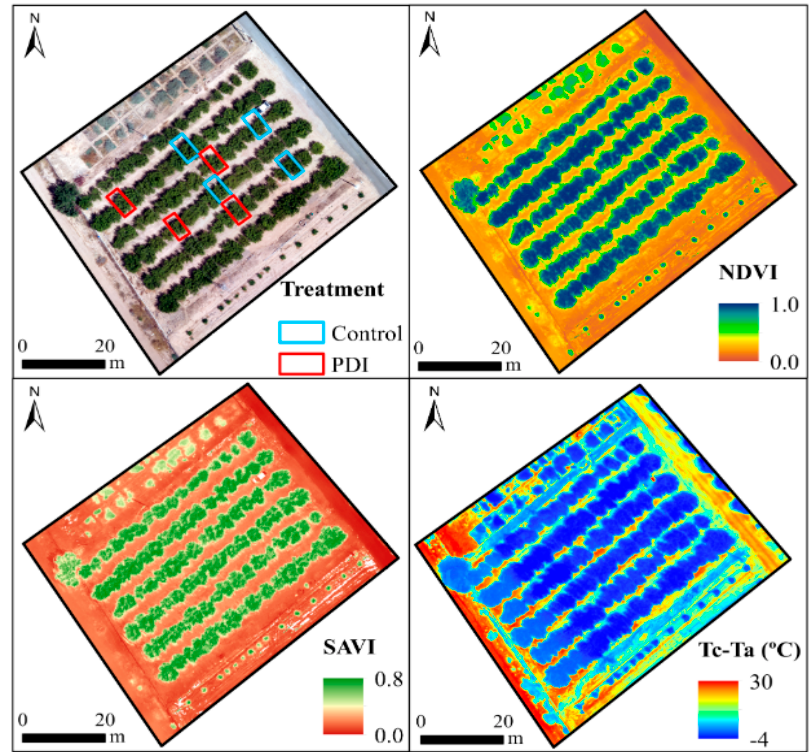
Figure 5. Spatial distribution of the selected soil-monitored trees and the derived indexes from the UAV imagery at t2 flight: normalized difference vegetation index (NDVI), soil adjusted vegetation index (SAVI), and canopy to air temperature difference (T c -T a, ºC).